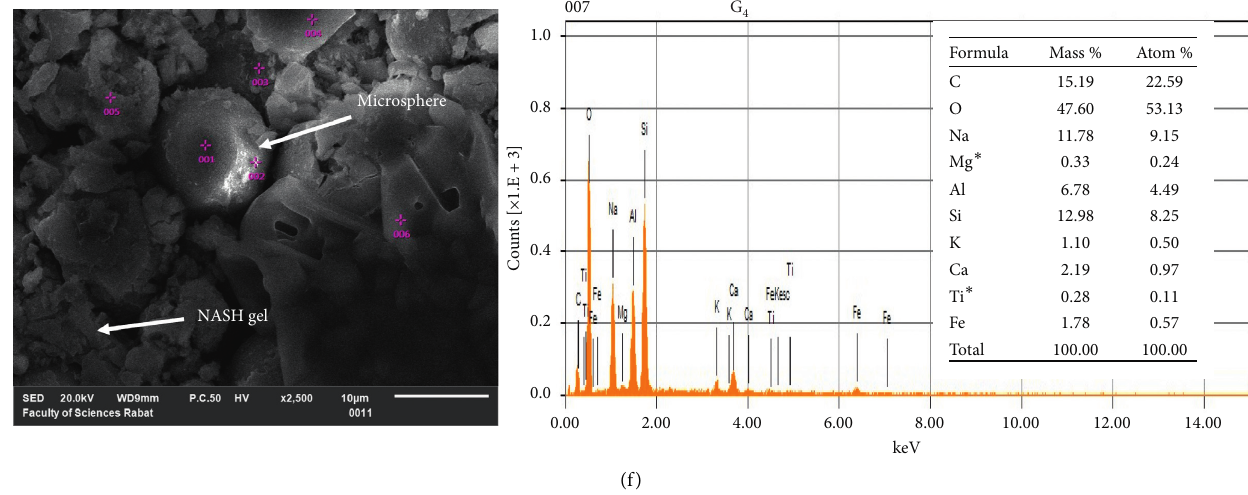
Figure 5: SEM micrographs of fly ash (a) and specimens with KOH/NaOH ratios, (b) G (d) G 2 (50% KOH; 50% NaOH), (e) G 3 (25% KOH; 75% NaOH), and (f) G 4 (100% NaOH).